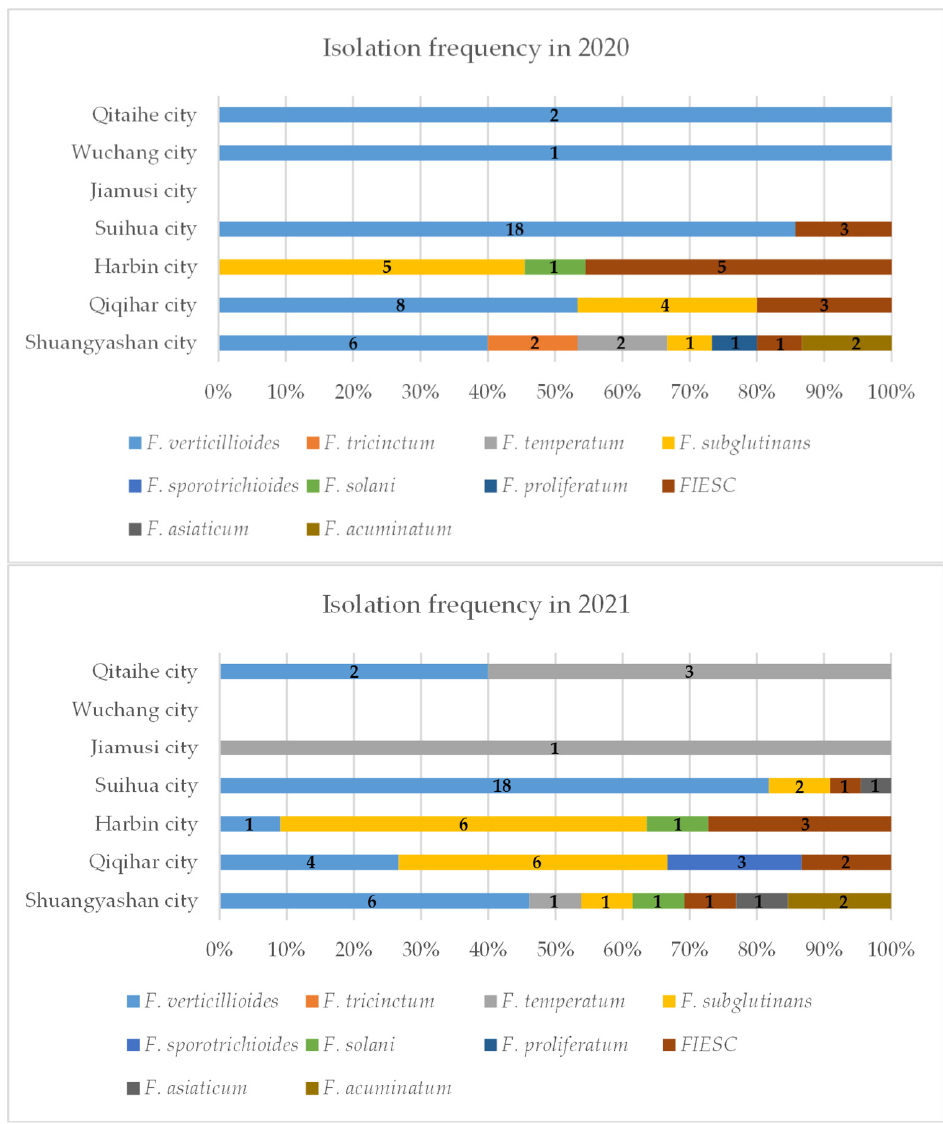
Figure 1. Isolation frequency of Fusarium isolates collected from 7 locations of Heilongjiang Province in 2020 and 2021, respectively. Table 1. The morphological characteristics of Fusarium species obtained in this study.